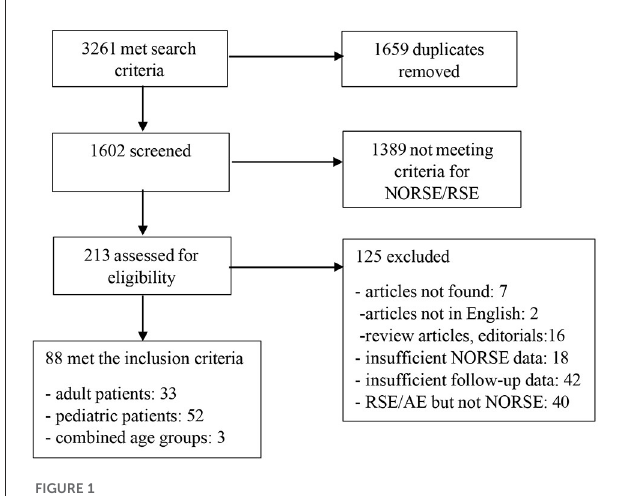
FIGURE1 Search strategy flow